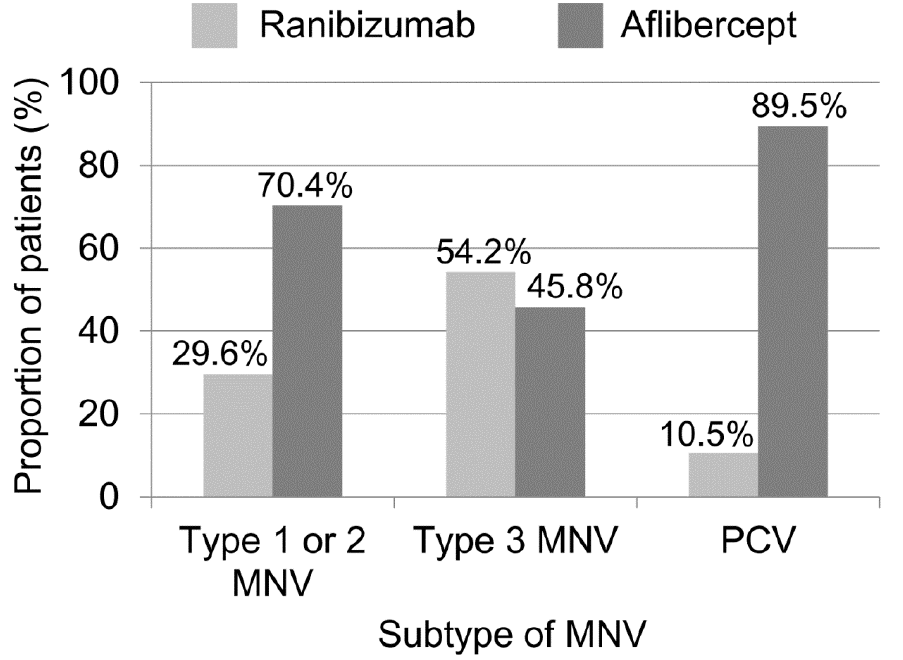
Figure 2. Proportion of patients who received ranibizumab or aflibercept as an initial treatment, according to the subtypes of macular neovascularization (MNV).